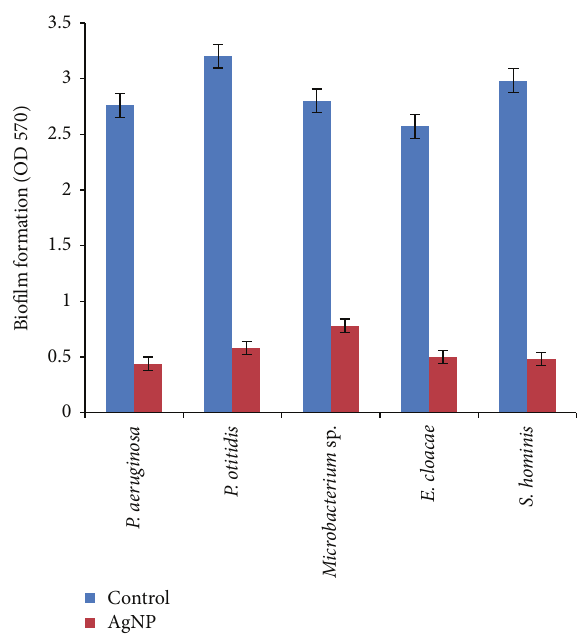
Figure 6: Antibiofilm activity of AgNPs on marine biofilm forming